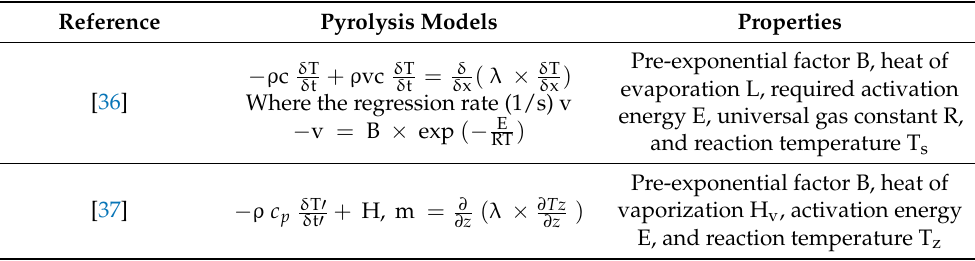
Table 3. Solid waste pyrolysis kinetic models [15].